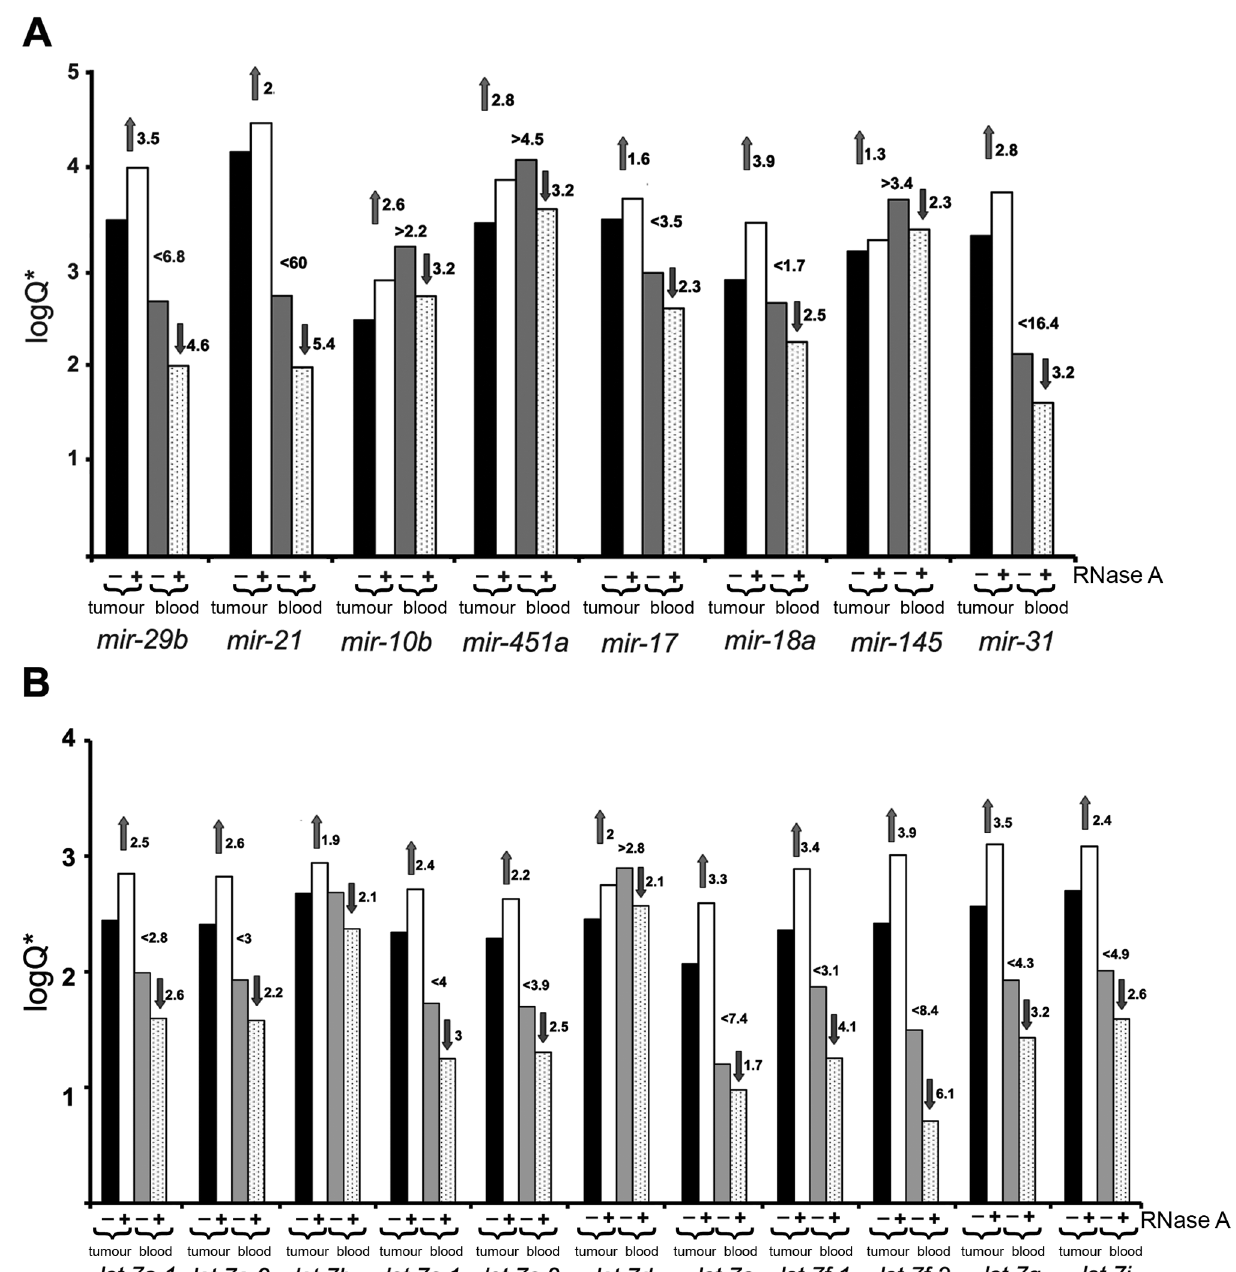
Figure 3. Logarithmic bar-graph depiction of the results of sequencing data. The typical pattern of changes in the levels of some oncogenic and tumour-suppressor miRNAs ( A ), and members of the let-7 miRNA superfamily ( B ) in LLC tumour tissue and serum of tumour-bearing mice after RNase A therapy. Q corresponds to reads per kb per million (RPKM)=number of reads of specific miRNA/(size of miRNA(kb) 6 total number of reads in the library(mln)). ‘‘ 2 ’’ – mice with LLC treated with saline buffer; ‘‘ + ’’ – mice with LLC treated with RNase A. Black and white bars reflect miRNA expression in tumour tissue, grey and spotted bars reflect miRNA level in the bloodstream.